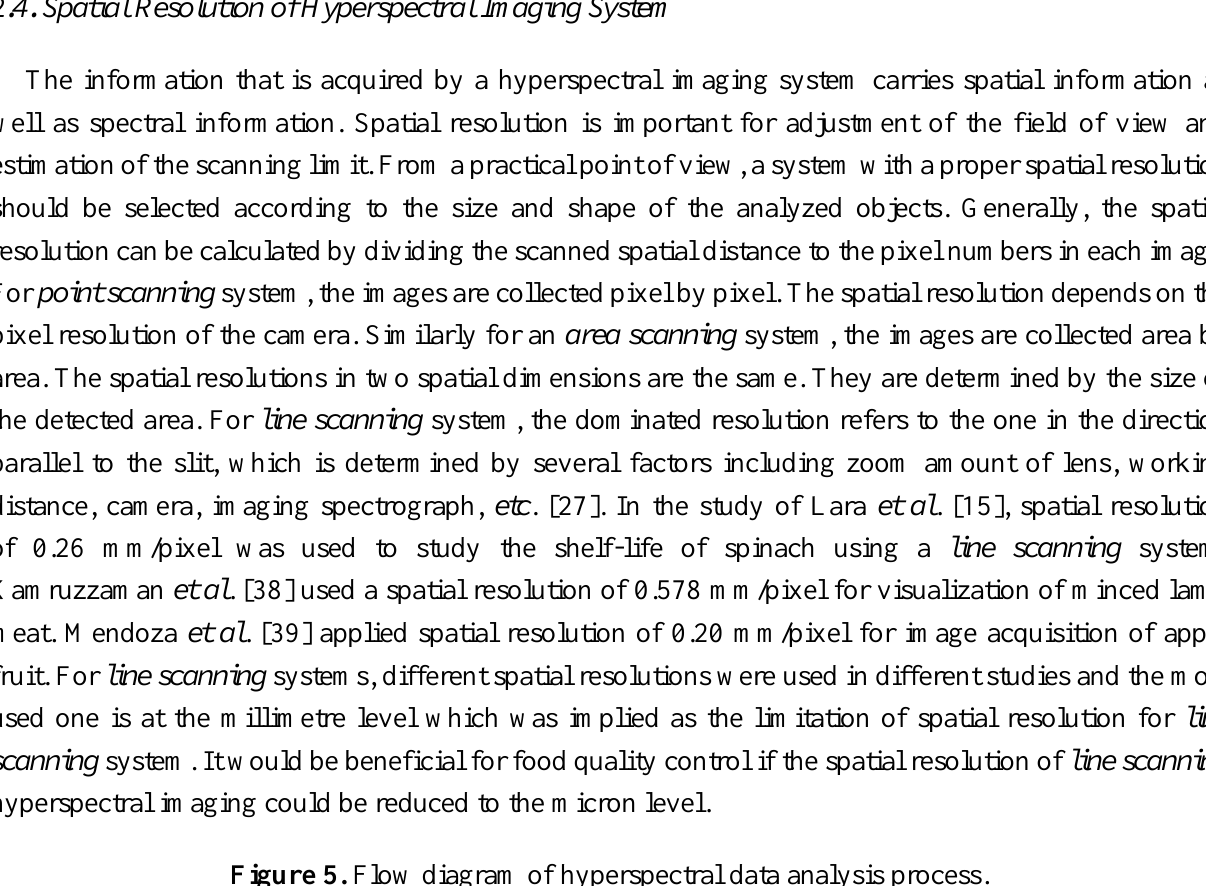
Figure 5. Flow diagram of hyperspectral data analysis